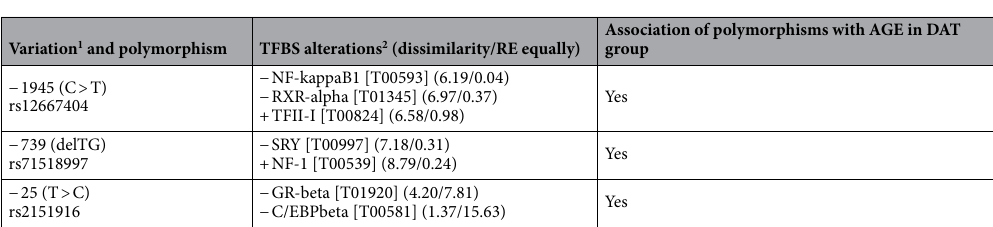
Variation 1 and